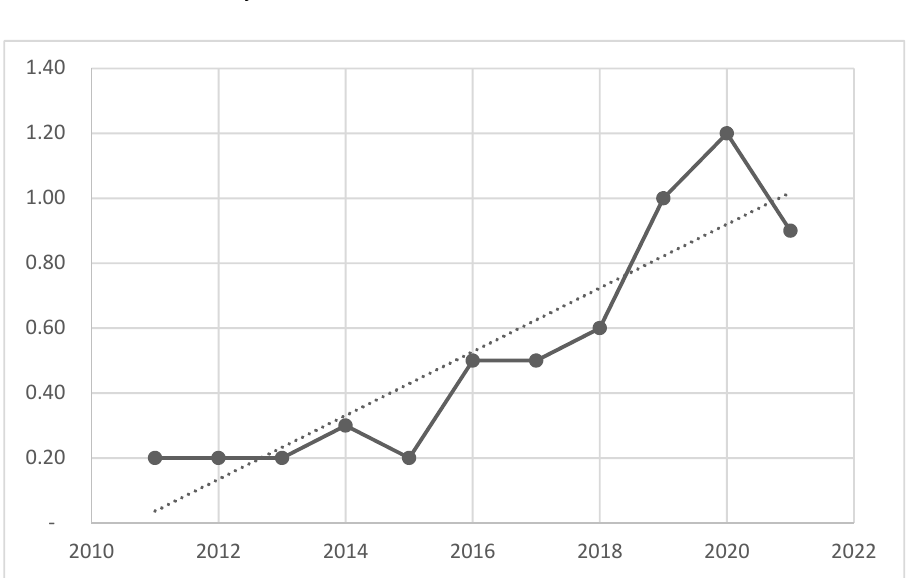
Figure 1. Cite Score of Jurnal Pengurusan (2011–2021).